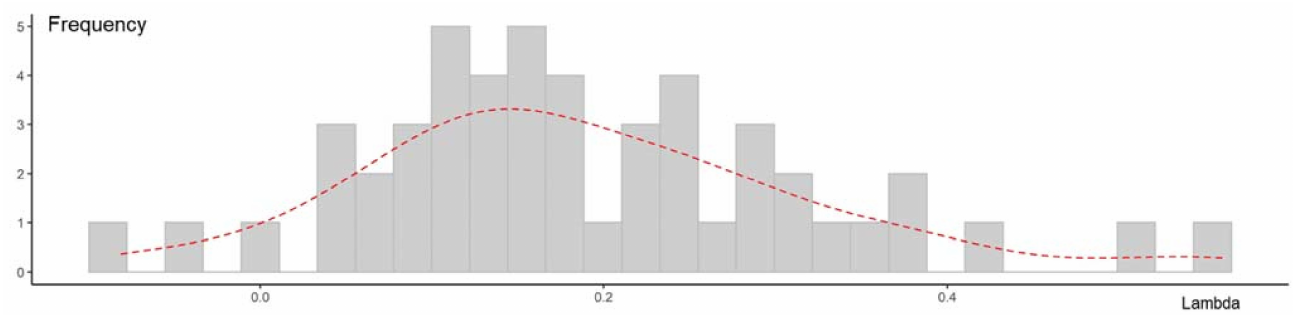
Figure 4. Histogram and density plot of spatial correlation coefficient λ . The grey bars in Figure 4 show the frequency of λ values, and the red line is the Probability Density Function (PDF) curve of the λ